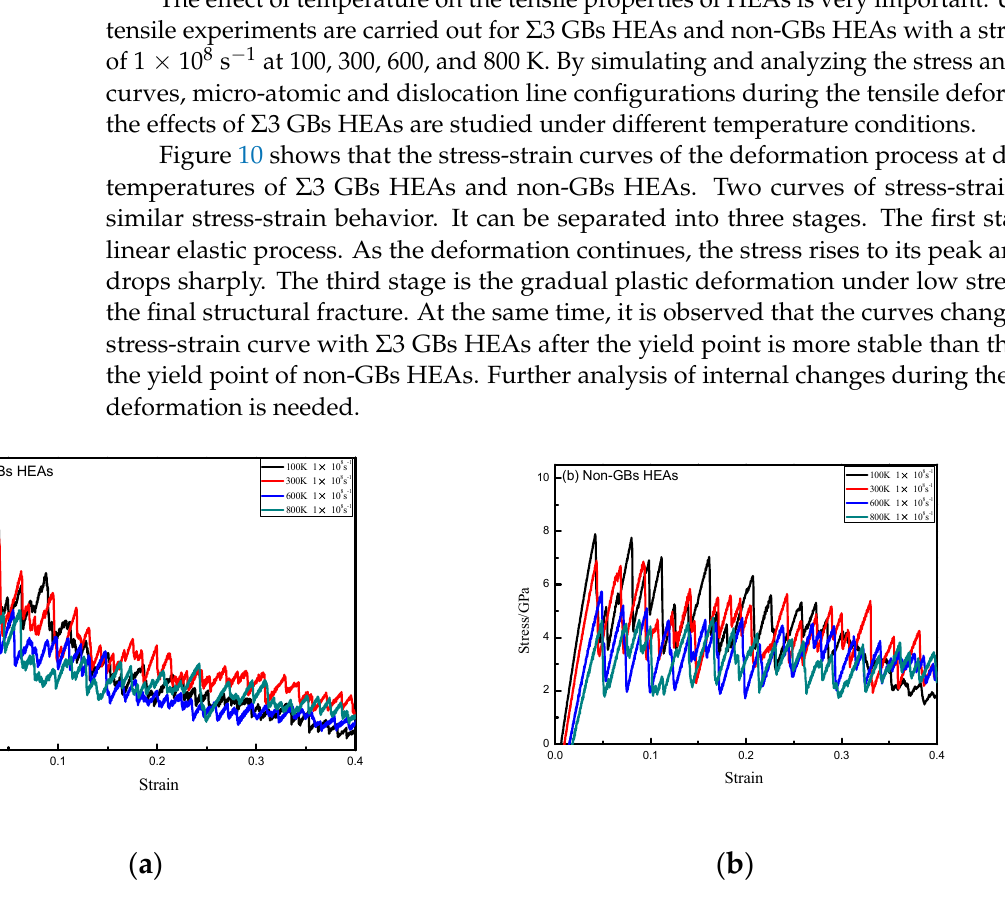
8 of 12 Figure 9. The DXA diagram of non-GBs HEAs under tensile. ( a ) 300 K, 1 × 10 8 s − 1 ; ( b ) 300 K, 1 × 10 9